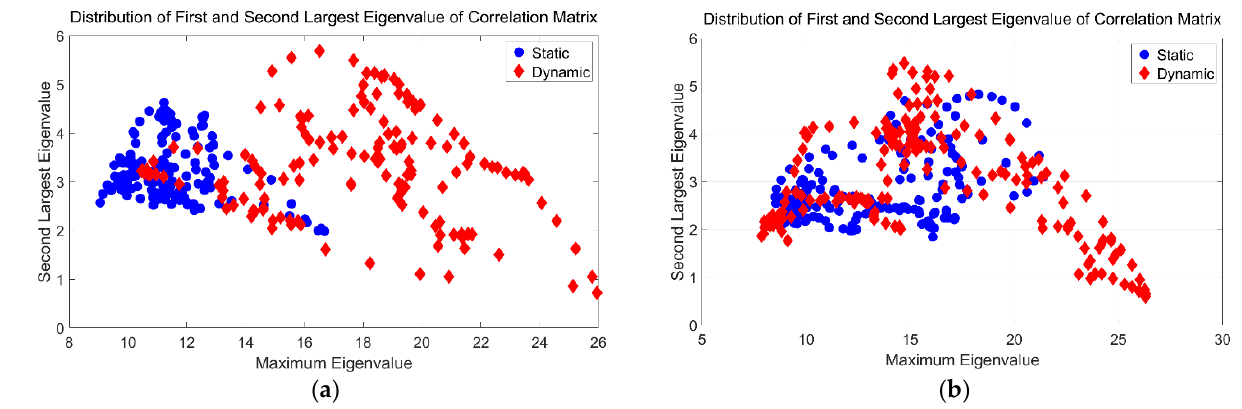
Figure 5. The distribution of first and second-largest eigenvalue of correlation matrix of static and dynamic status under different sliding windows. ( a ) Sample sliding window 1 shows a relatively clear gap between static and dynamic status; ( b ) Sample sliding window 2 shows no clear gap between static and dynamic status.